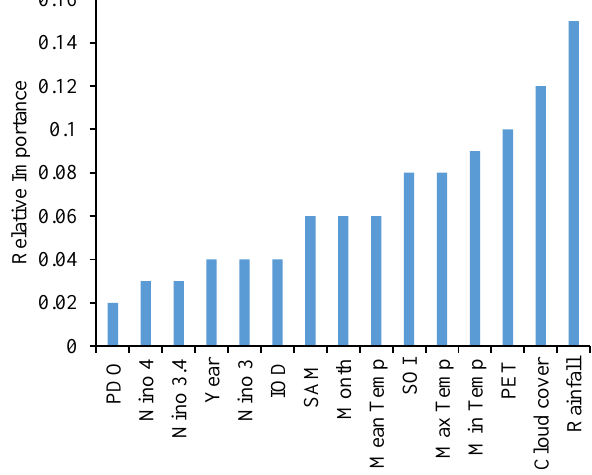
Figure 5. Relative importance plot of the variables for the ANN model.